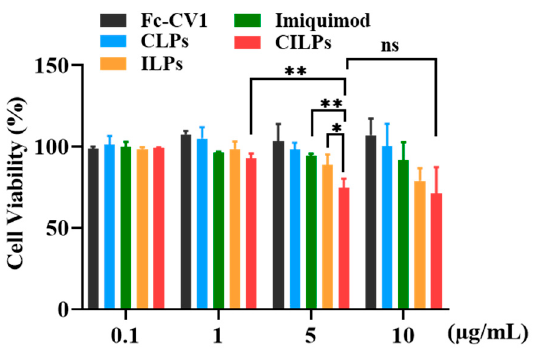
Figure 4. The viability of the cells treated with Fc-CV1, imiquimod, CLPs, ILPs, and CILPs for 24 h. The concentration of the Fc-CV1 and imiquimod were both 0–10 µg/mL. * p < 0.05, ** p < 0.01, ns = no signi fi cant di ff erences.